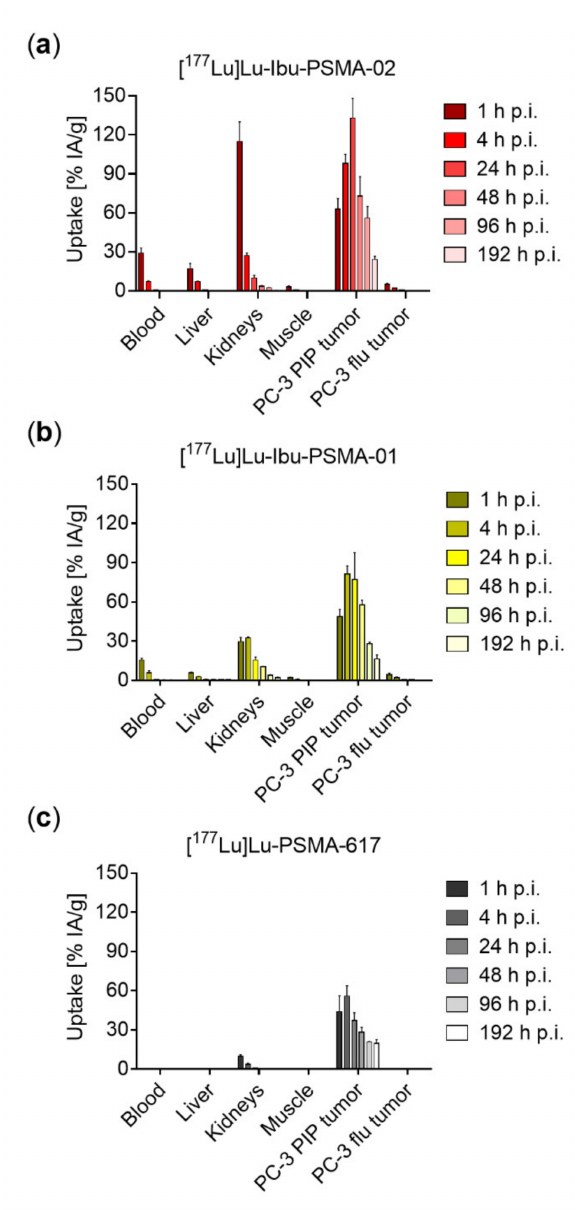
Figure 4. Graphs showing decay-corrected biodistribution data of [ 177